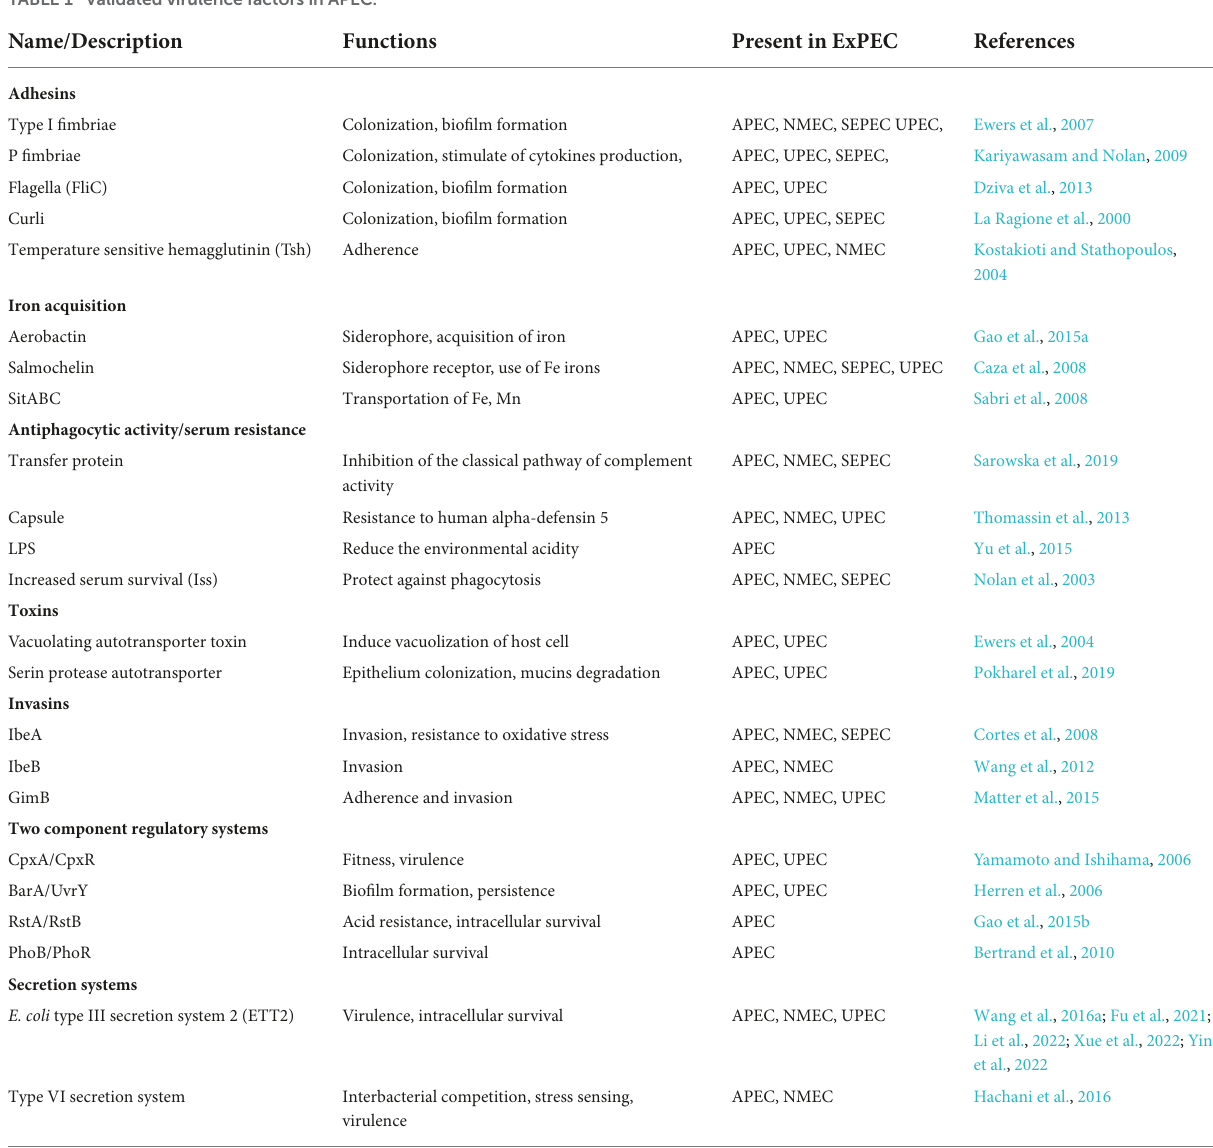
TABLE 1 Validated virulence factors in